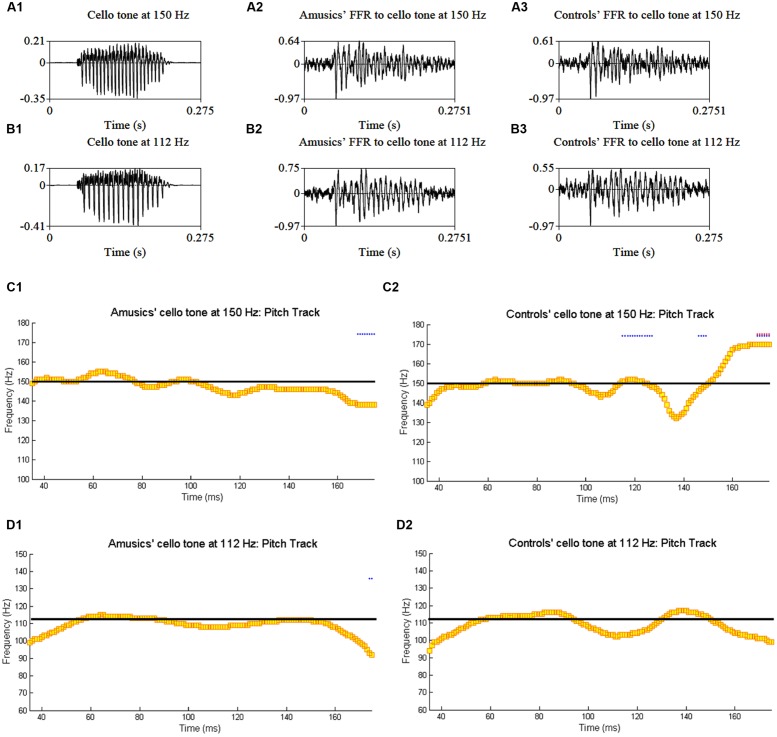
Waveforms of the original two cello tones (A1,B1), and grand average waveforms of the FFRs to the cello tones (heard in quiet) of the amusic (A2,B2) and control (A3,B3) groups, and the corresponding pitch tracks (C1,C2,D1,D2).